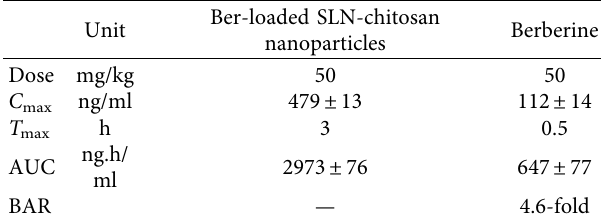
BAR — 4.6-fold AUC, area under the berberine plasma concentration-time curve; BAR, the relative bioavailability of oral administration of Ber-loaded SLN-chitosan nanoparticles compared with the pure berberine suspension; C max , the maximum plasma concentration of berberine after oral administration; T max , the time to maximum plasma concentration of